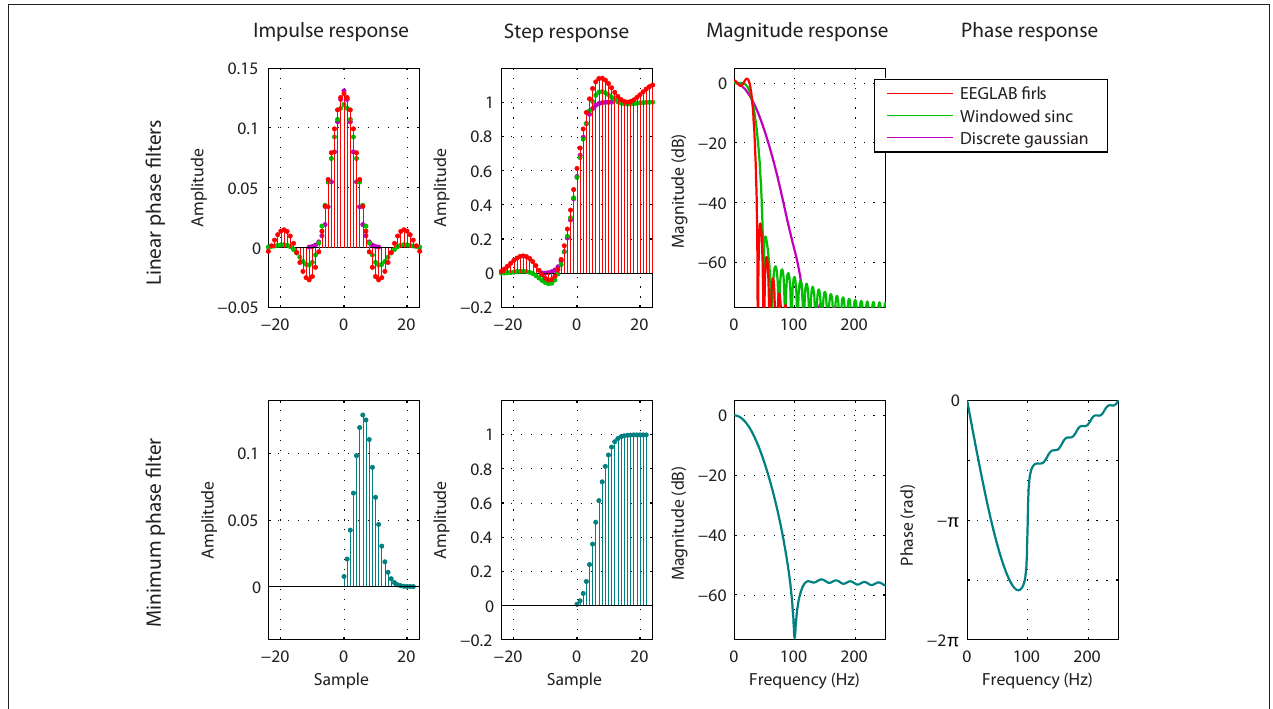
Figure A1 | Prototypical low-pass linear-phase filters’ impulse, step, magnitude, and phase responses (top row; sampling frequency = 500 Hz, cutoff frequency 30 Hz). The EEGLAB “Basic FIR filter” (red, 49 points, default settings, EEGLAB v11.0.2.1b; Delorme et al., 2011) exhibiting excessive ringing artifacts (“ripples” in the time domain observed if filtering a non-oscillating input, e.g., a step signal, yields an oscillating output) is shown in comparison to a